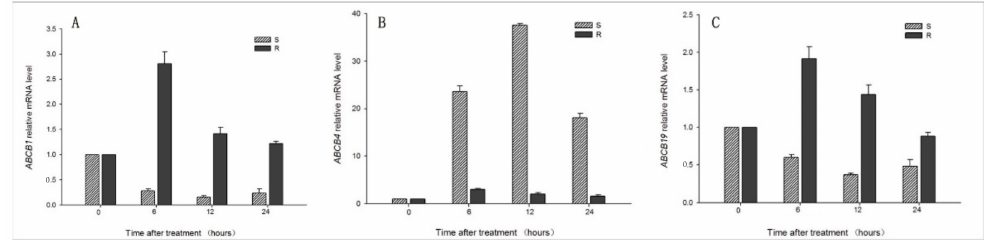
Figure 7. Relative transcript level in roots of 3 candidate genes after treatment with quinclorac in S (susceptible, JNNX-S) and R (resistant, SSXB-R) biotypes. ( A – C ) represent the EcABCB1 , EcABCB4 and EcABCB19 .